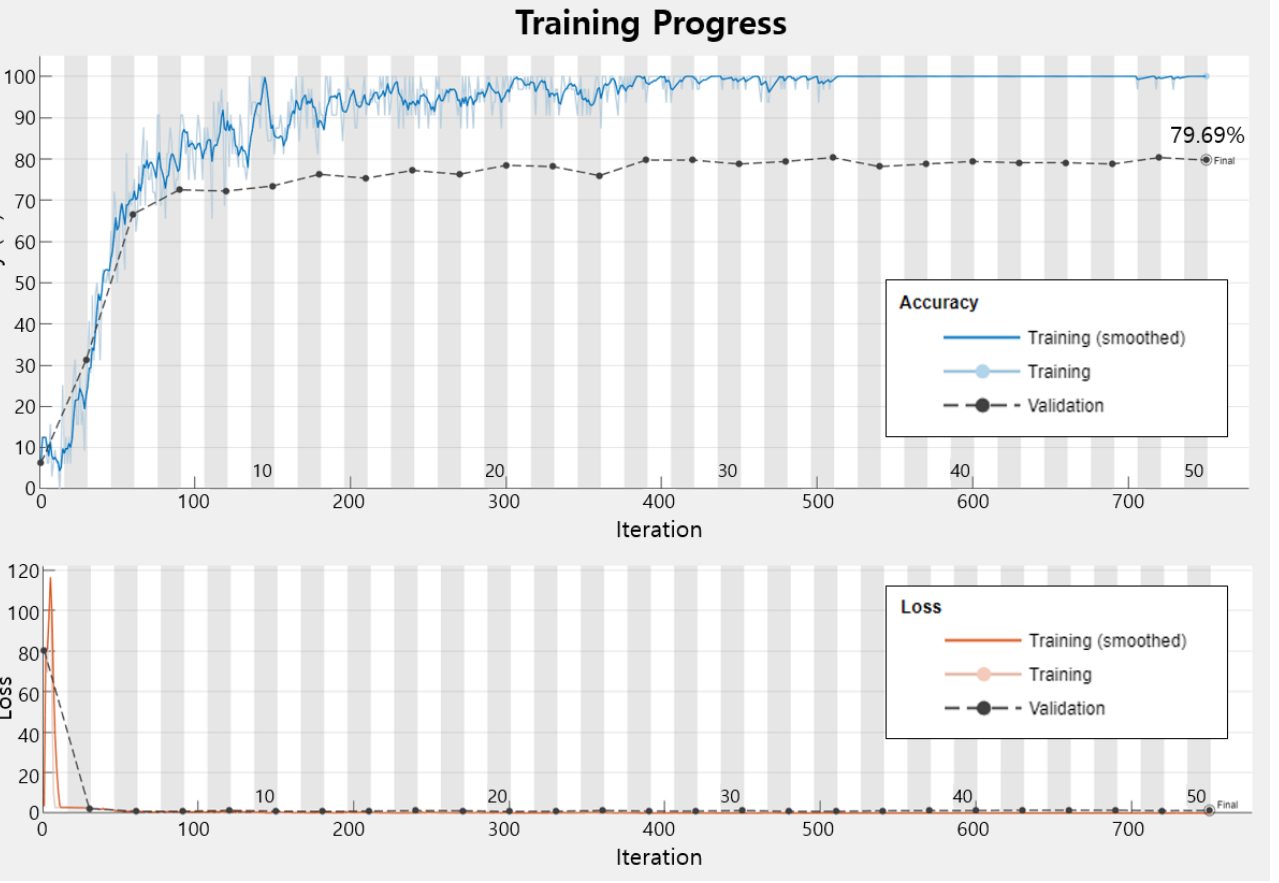
Every epoch Table 8. Testing accuracy.